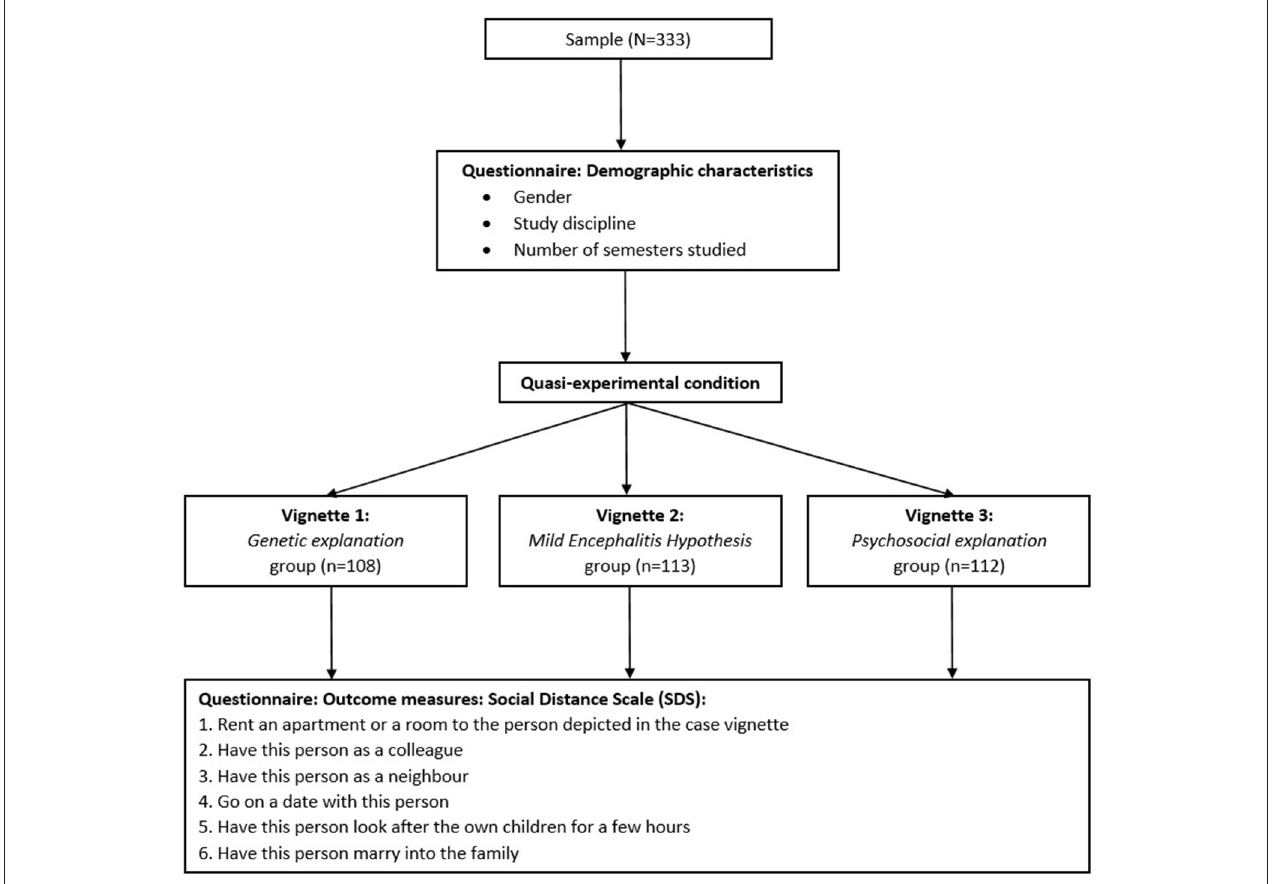
FIGURE 1 | Flow chart displaying the experimental design of the vignette study and the participant